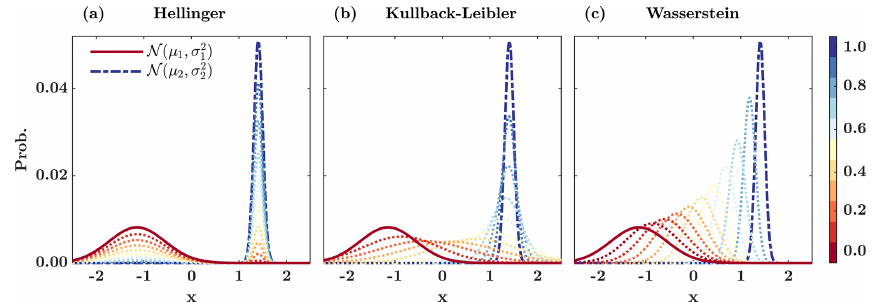
= 0 . 4, and σ 2 = 1 2